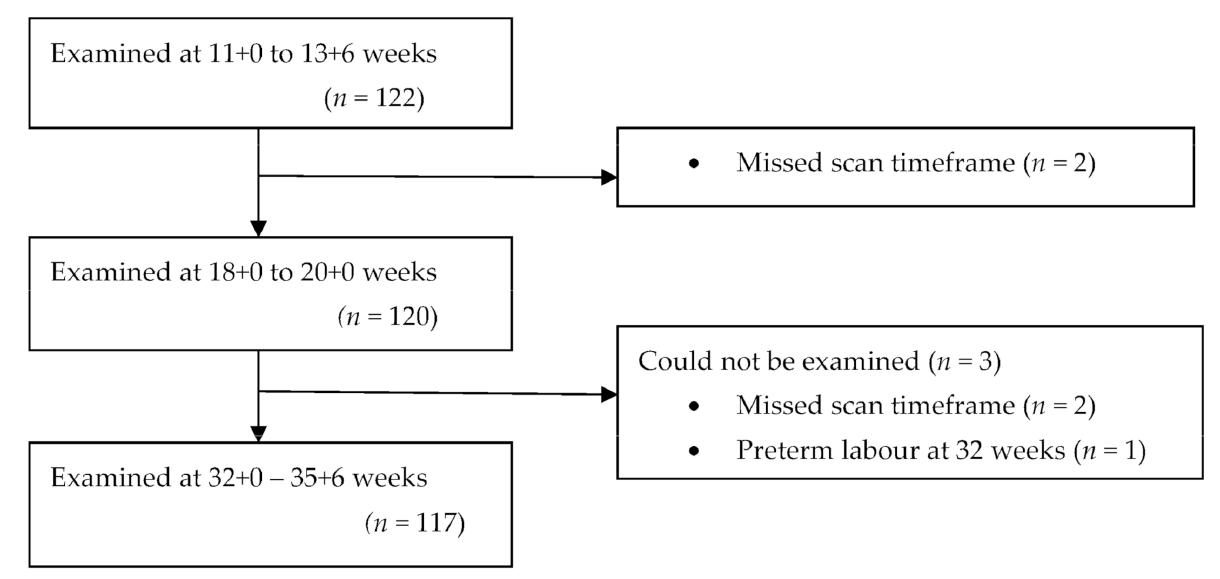
Figure 3. Flowchart of participants through the study